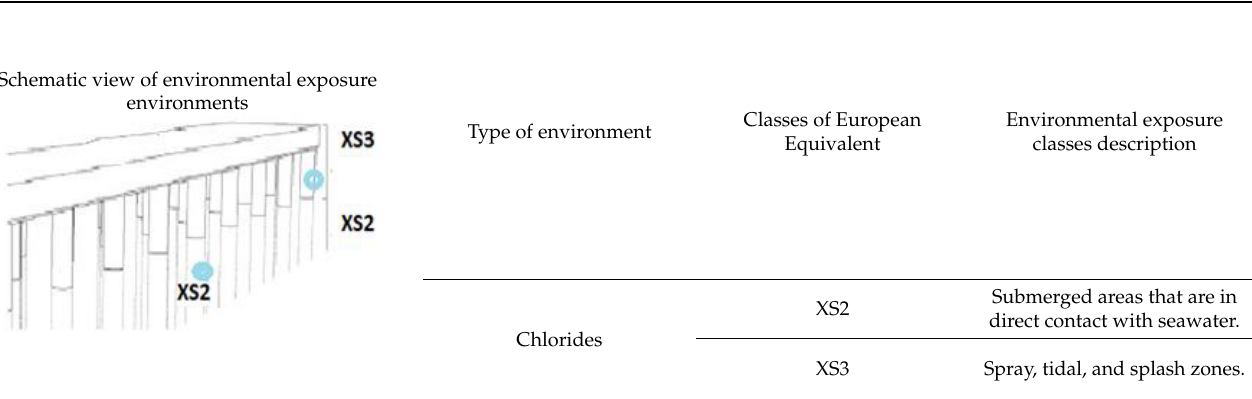
Table 2. Environmental exposure classes of corrosion: EN 1992-1-1 (2004) [46] and EN 206-1 (2005) [43].